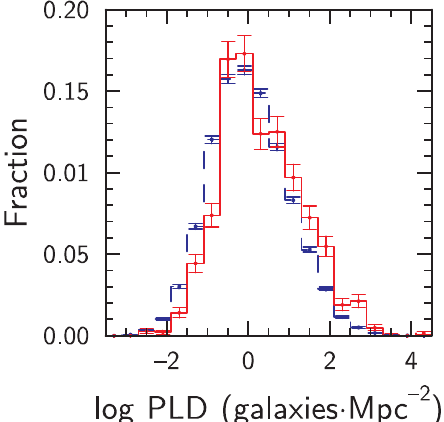
Fig. 4. Local density distribution for the pair subsample and the control sample. Designations are the same as in Figure